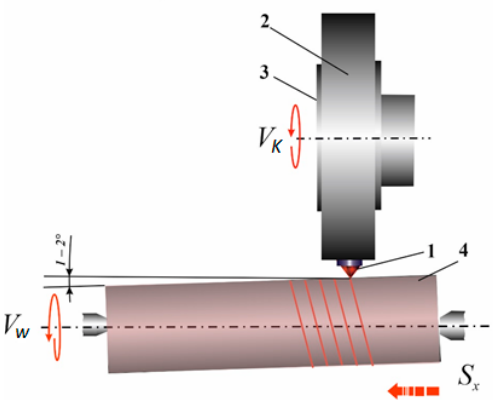
Figure 2. Scheme of cutting-scratching of a part with a diamond cone and an abrasive bar on a circular grinding machine.